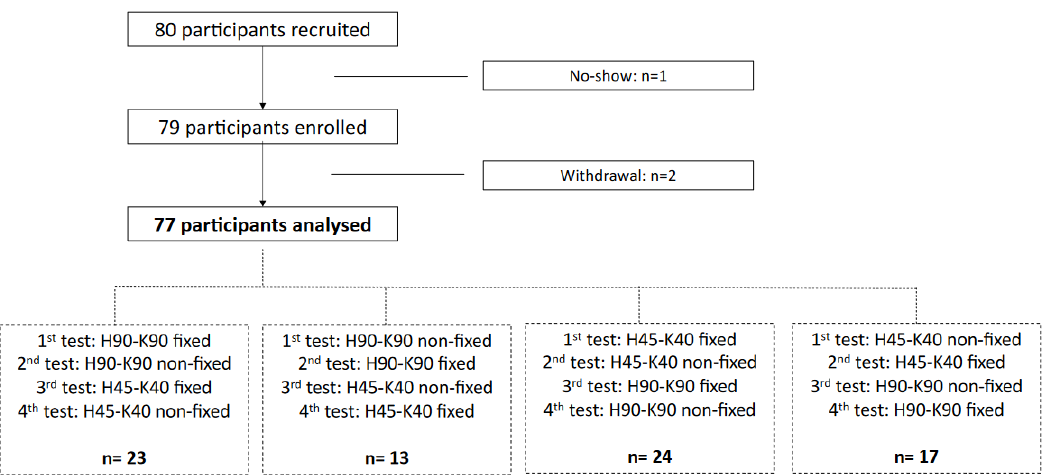
Figure 2. Flow chart, detailing the order of the tests among the included participants.